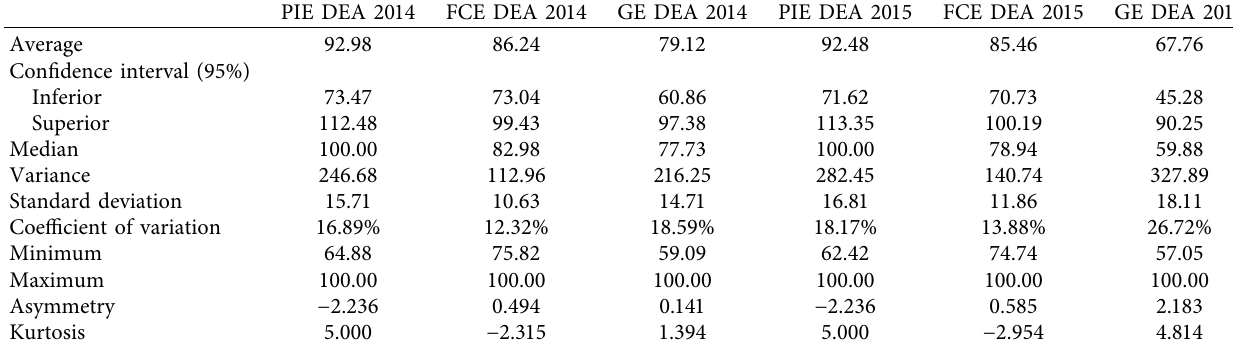
Table 4: Descriptive statistics by year and dataset Private.